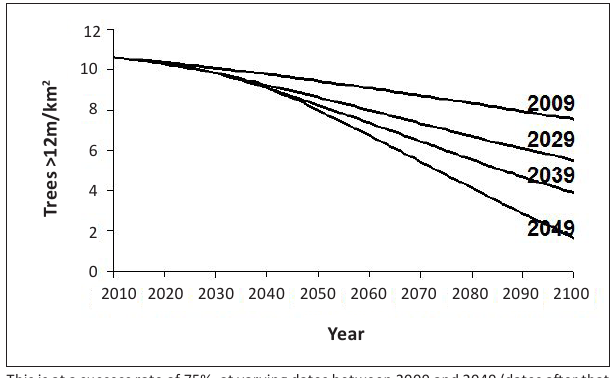
This is at a success rate of 75%, at varying dates between 2009 and 2049 (dates after that make no difference to the date at which large trees fall below the threshold). FIGURE 3: The effect of the year of commencement of elephant contraception on the decline of large